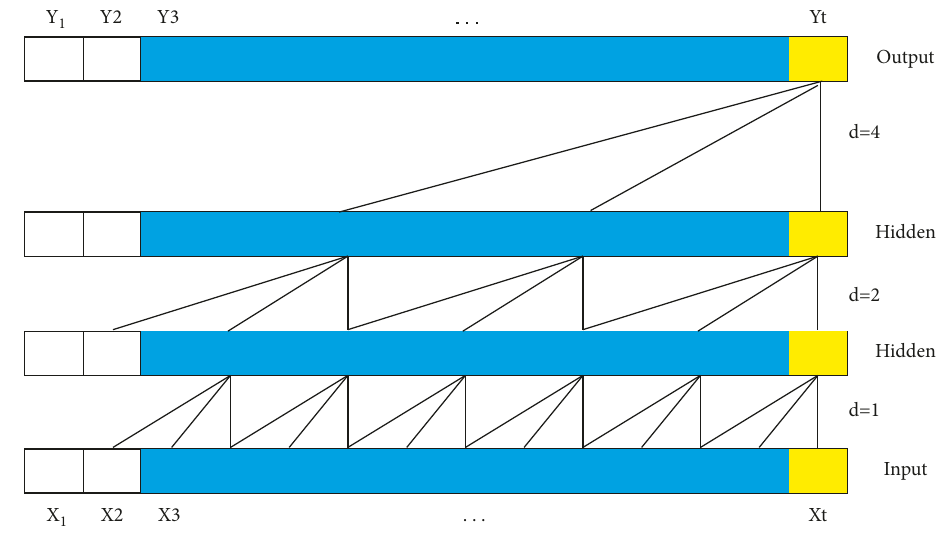
Figure 3: TCNN architecture